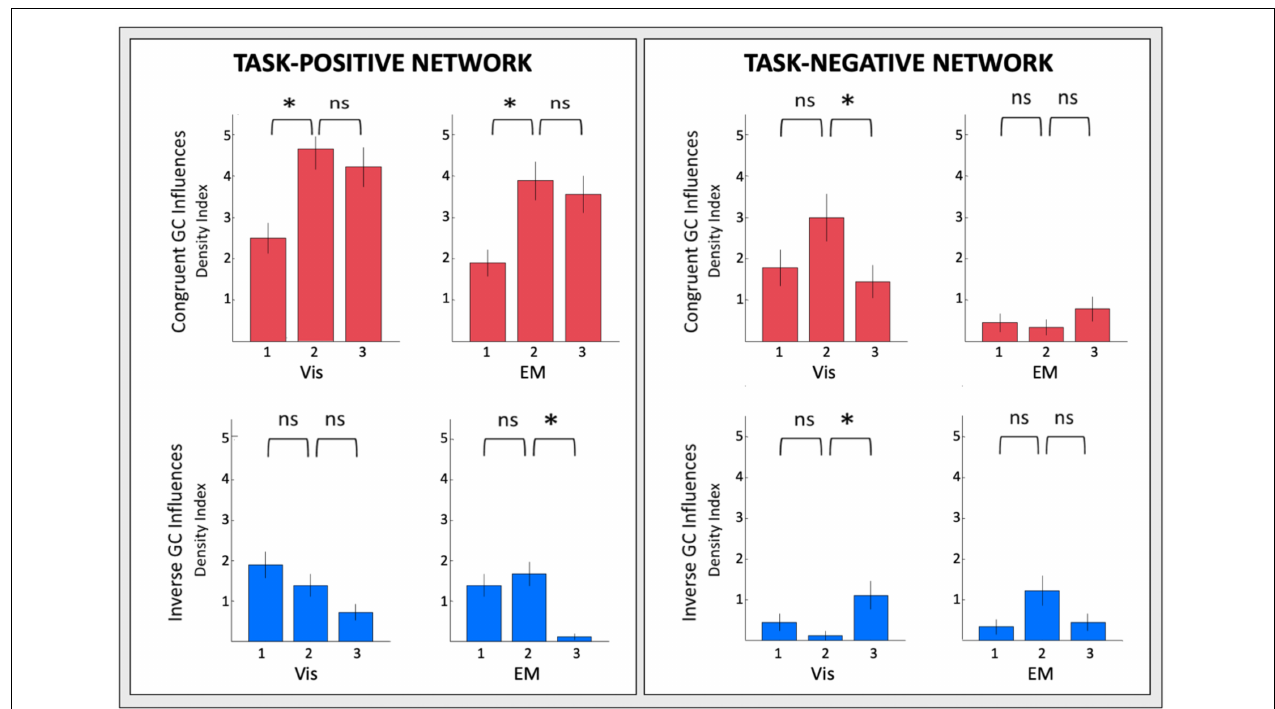
FIGURE 14 | Overview of the density of connections under each circular plot of Figures 9–12 . Error bars are 1 SEM of the counts. Sequential pairwise differences significant at p < 0.05 are indicated by